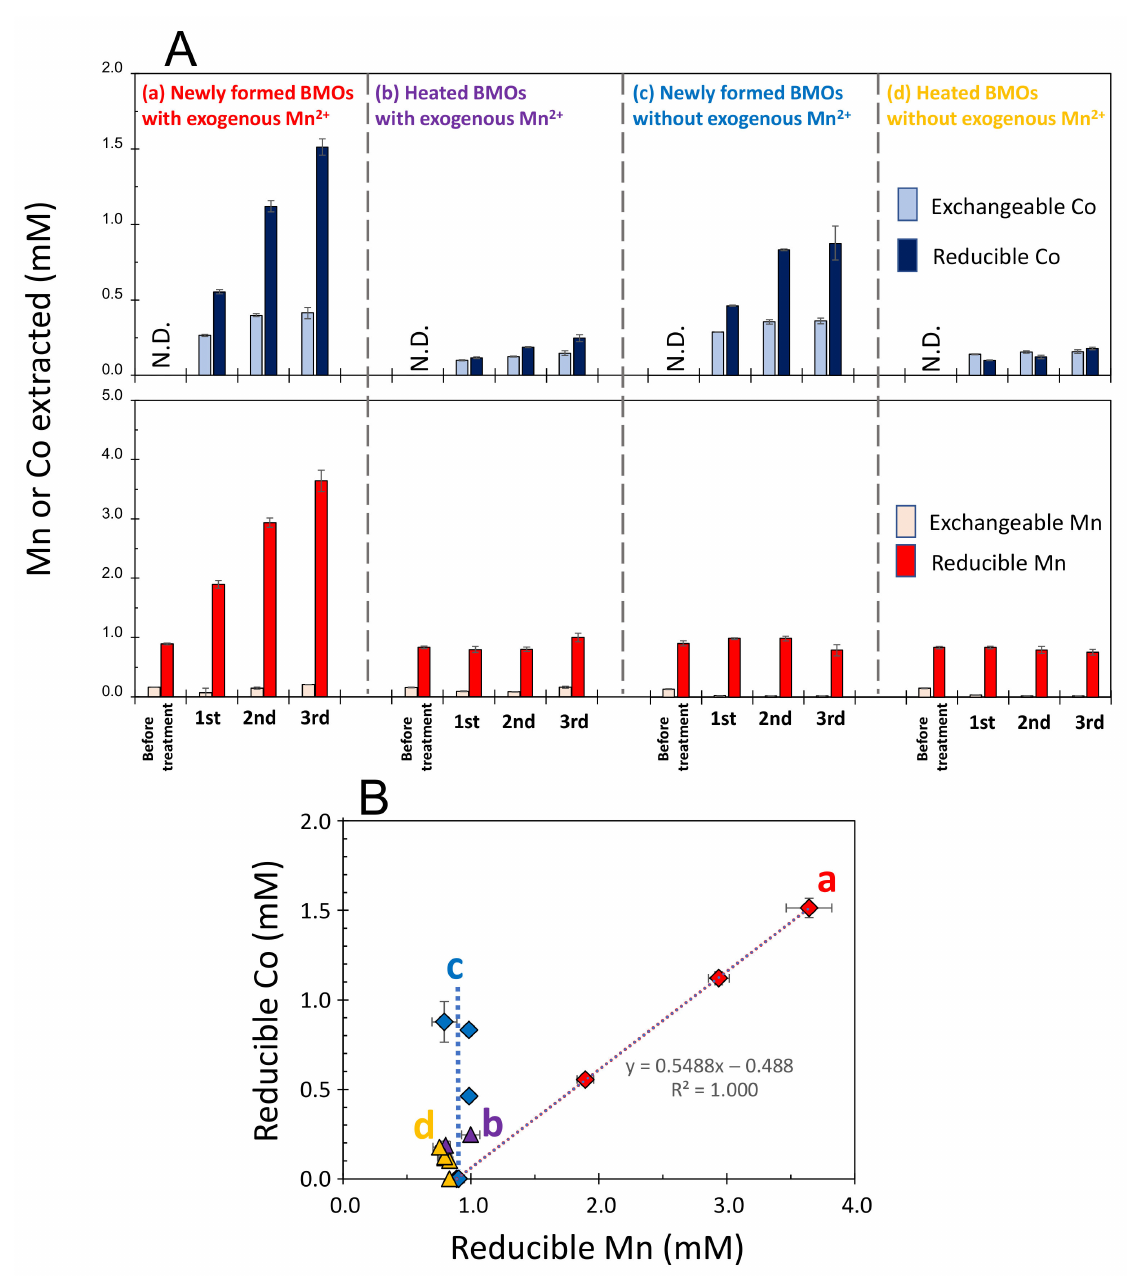
Figure 2. Two-step extraction of biogenic manganese oxides (BMOs) during repeated treatment experiments. ( A ) Co and Mn in exchangeable and reducible phases in the resultant BMOs. Newly formed ( a , c ) and heated ( b , d ) BMOs (1 mM as Mn) were treated in 0.8 mM Co 2+ solutions with ( a , b ) and without ( c , d ) 0.8 mM exogenous Mn 2+ under aerobic conditions at pH 7.0 (100 mM HEPES buffer). ( B ) Reducible Co concentrations plotted against reducible Mn concentrations. Bathing solutions were renewed every 24 h. Data are the mean ± standard deviation ( n = 3 or